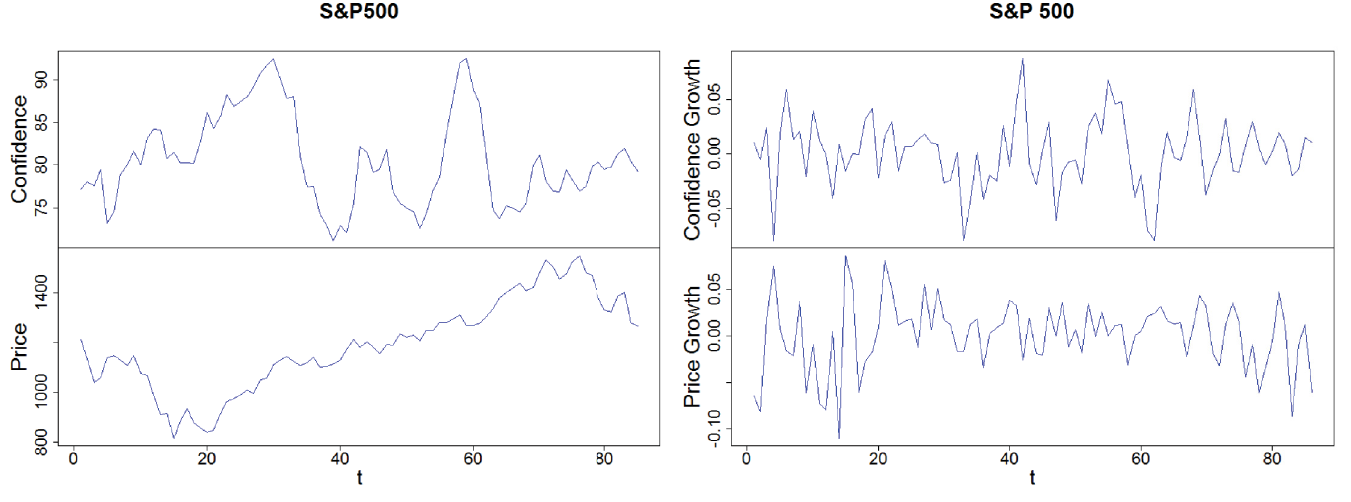
Fig 11. Time series illustrating the confidence index and the stock price for the S&P 500 (on the left) and the growth rate of the indices (on the right). Source: Own creation.